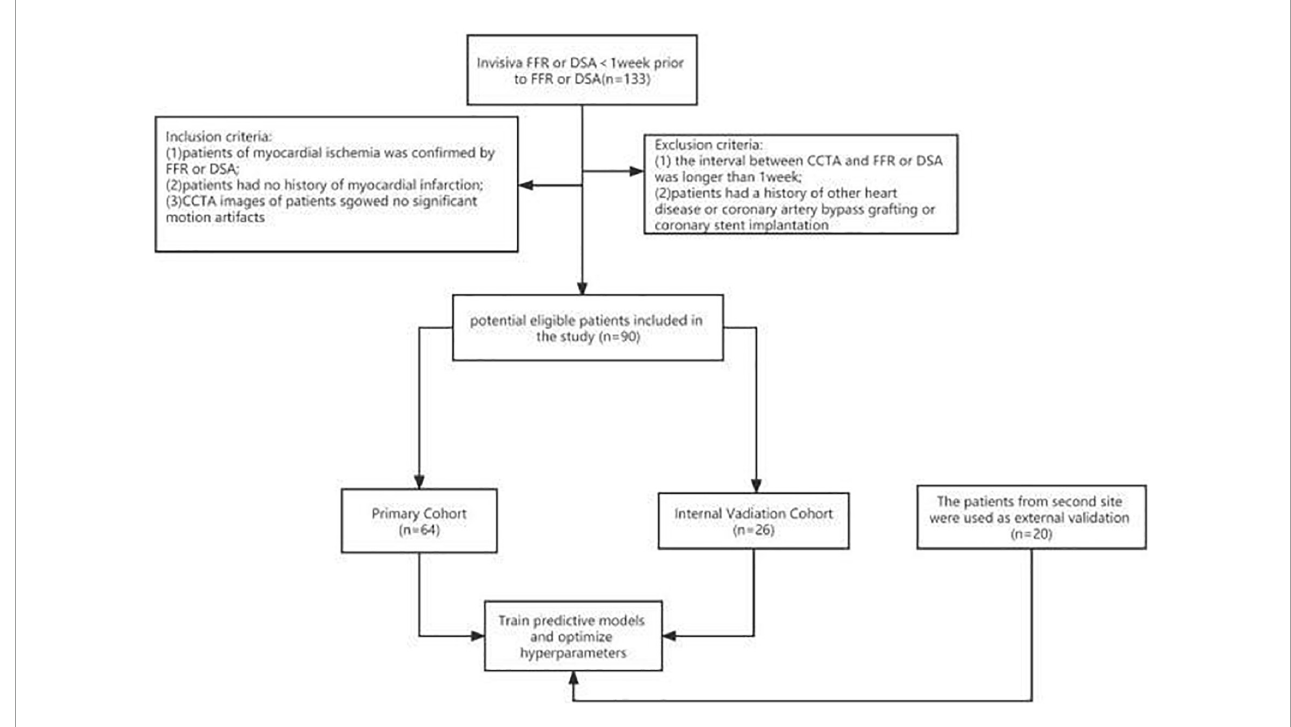
FIGURE1 Flowsheet of patient selection.